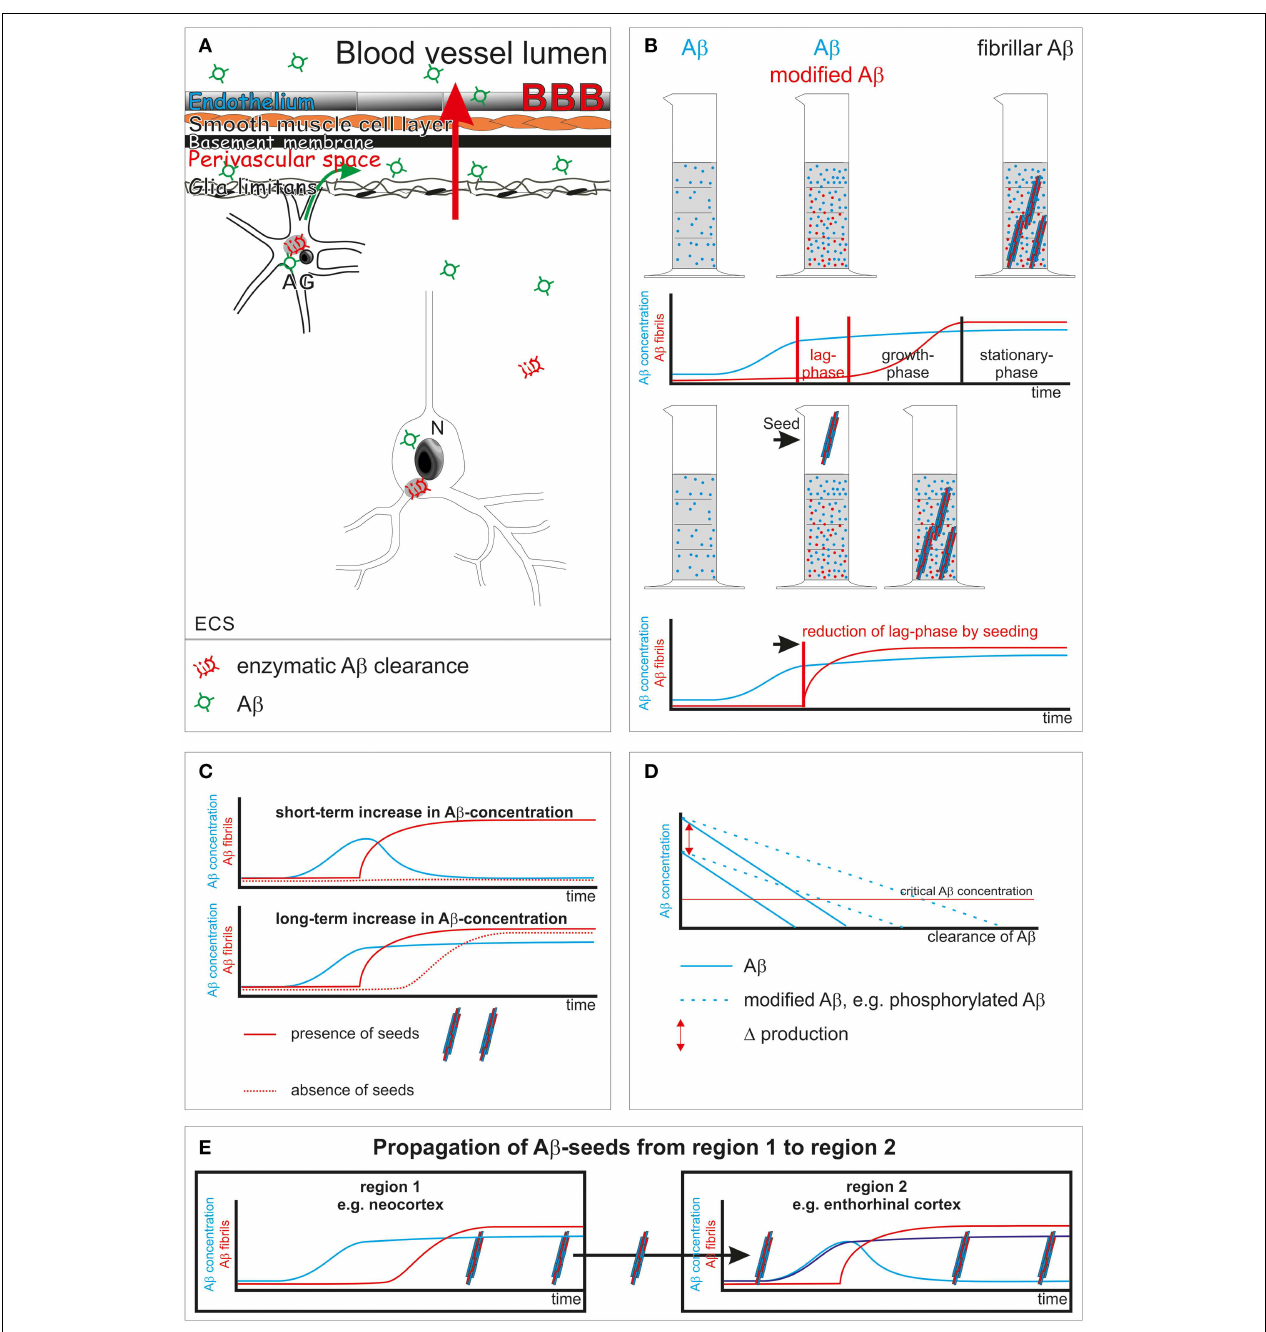
FIGURE 1 | Schematic representation of A β clearance and propagation. (A) A β clearance mechanisms: enzymatic clearance within neurons (N) and glial cells [here shown in the example is an astrocyte (AG)] or in the extracellular space (ECS) (Qiu et al., 1998; Yamaguchi et al., 1998; Iwata et al., 2000; Thal et al., 2000; Farris et al., 2003); transport through the blood-brain barrier (BBB) into the blood (red arrow) ( Shibata et al., 2000; Ito et al., 2007); drainage into the perivascular space (green arrow) (Weller et al., 2008). (B) A β aggregation into fibrils shows a lag-phase that is reduced by the presence of seeds (Thal et al., 2015). (C) Initiation of A β fibril formation in the presence of seeds starts immediately after a critical concentration is passed even for a short period of time. In the absence of seeds a longer increase of A β concentration may be necessary to pass the lag-phase for